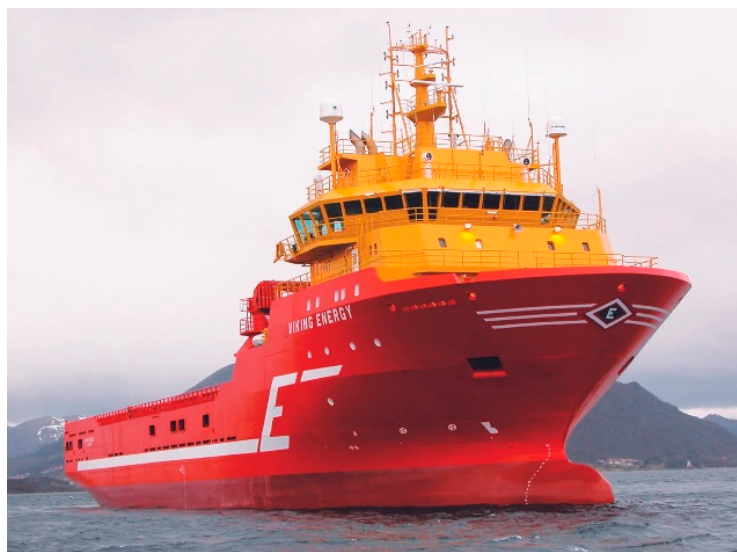
Figure 11. The ocean engineering vessel “Viking Energy” [68].